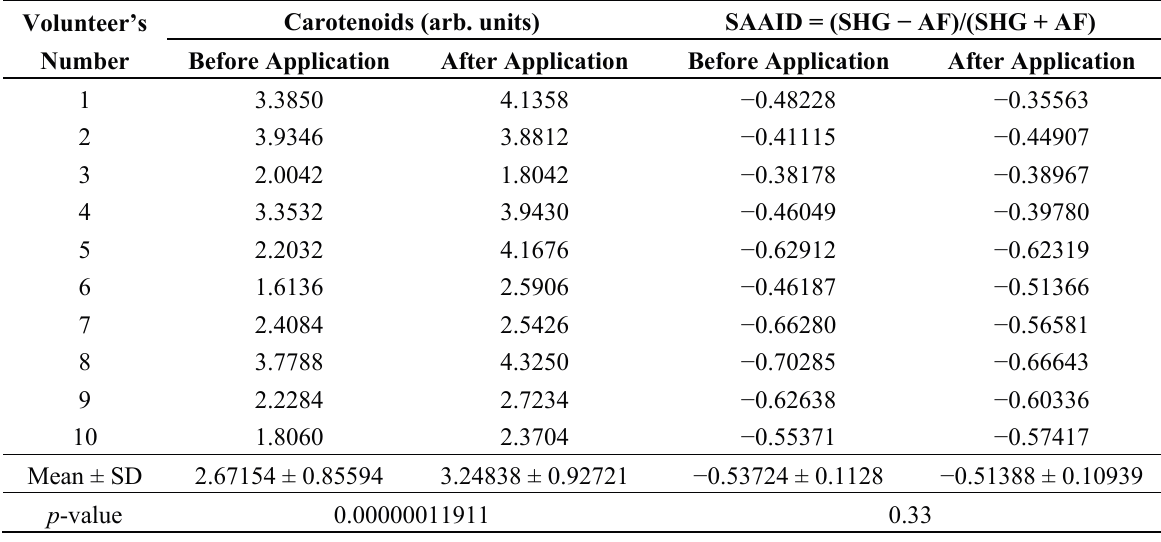
Table 1. Cutaneous carotenoids and SAAID before and after oral intake of Spirulina platensis .